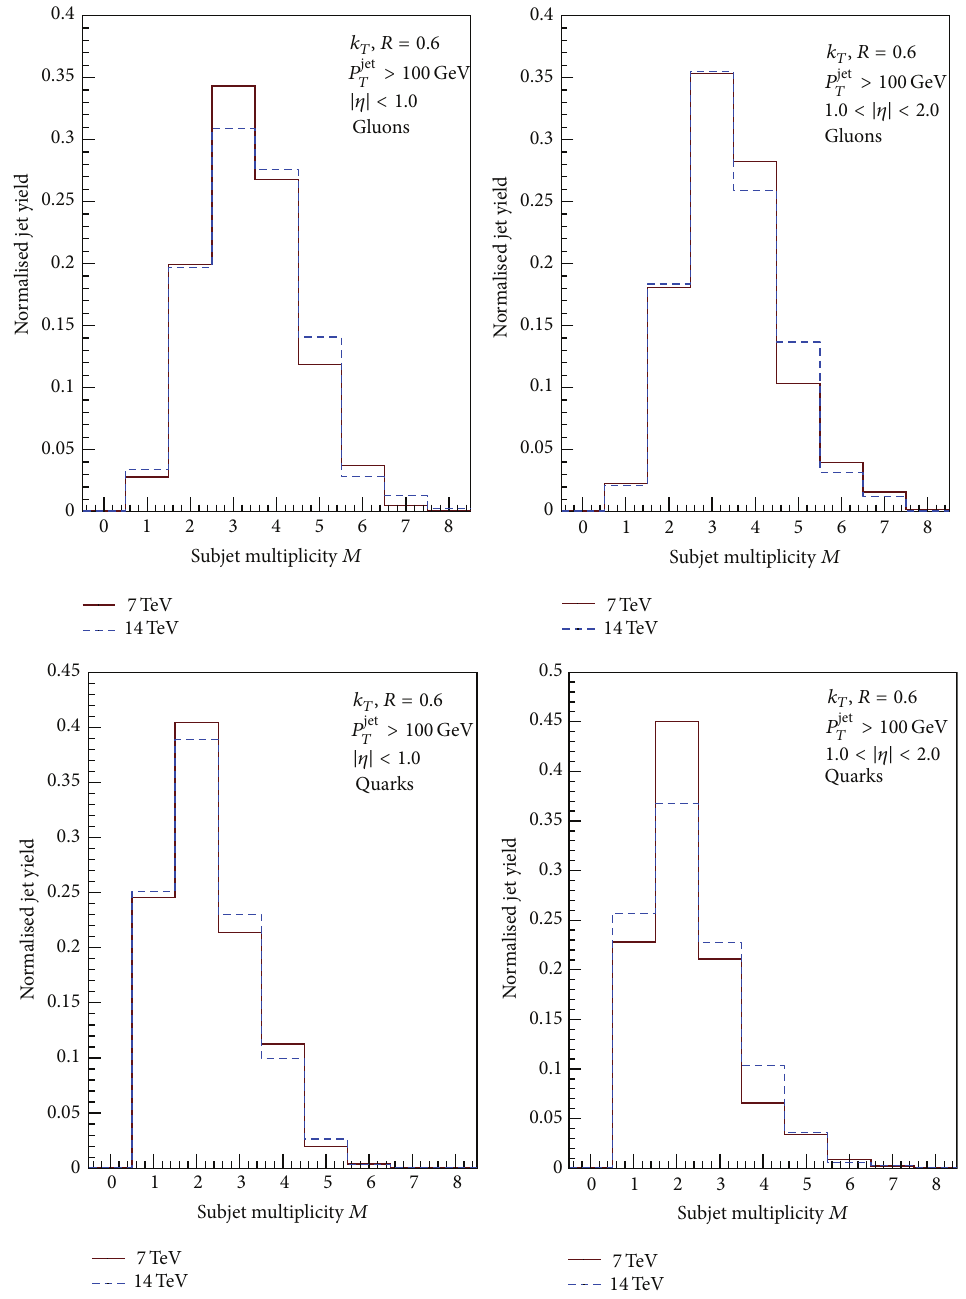
Figure 5: Subjet multiplicity distributions for jets matched to gluons (top) and quarks (bottom), having 𝑃 jet 𝑇 > 100 GeV, in the pseudorapidity bins of |𝜂| < 1 (left) and 1 ≤ |𝜂| < 2 (right) at √𝑠 = 7 TeV and √𝑠 = 14 TeV from 𝑘 𝑇 algorithm.